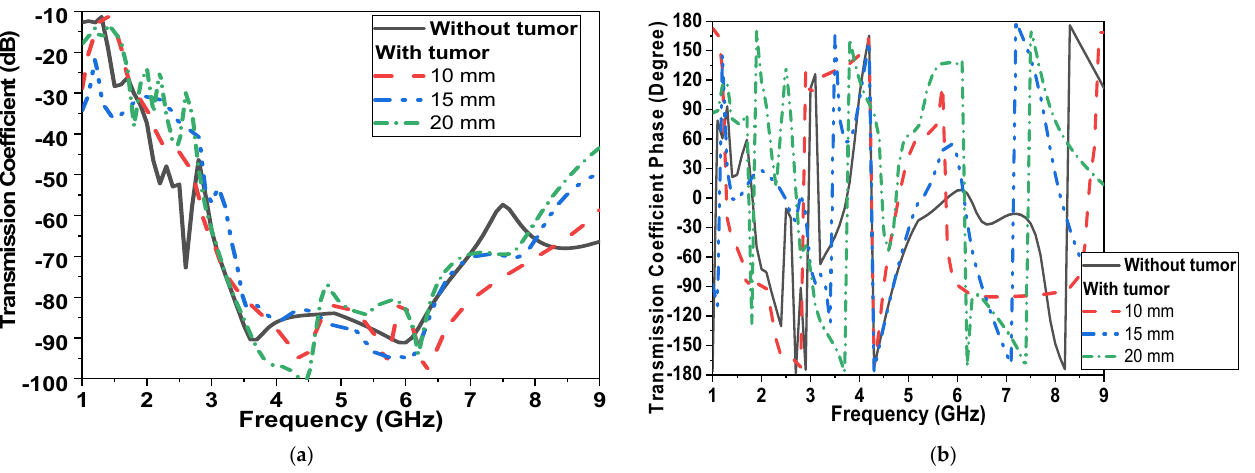
Figure 13. Simulated |S 21 | of proposed CPMS with tumor model (second scenario shown in Figure 10b) ( a ) Magnitude in dB, ( b ) Phase in degrees.